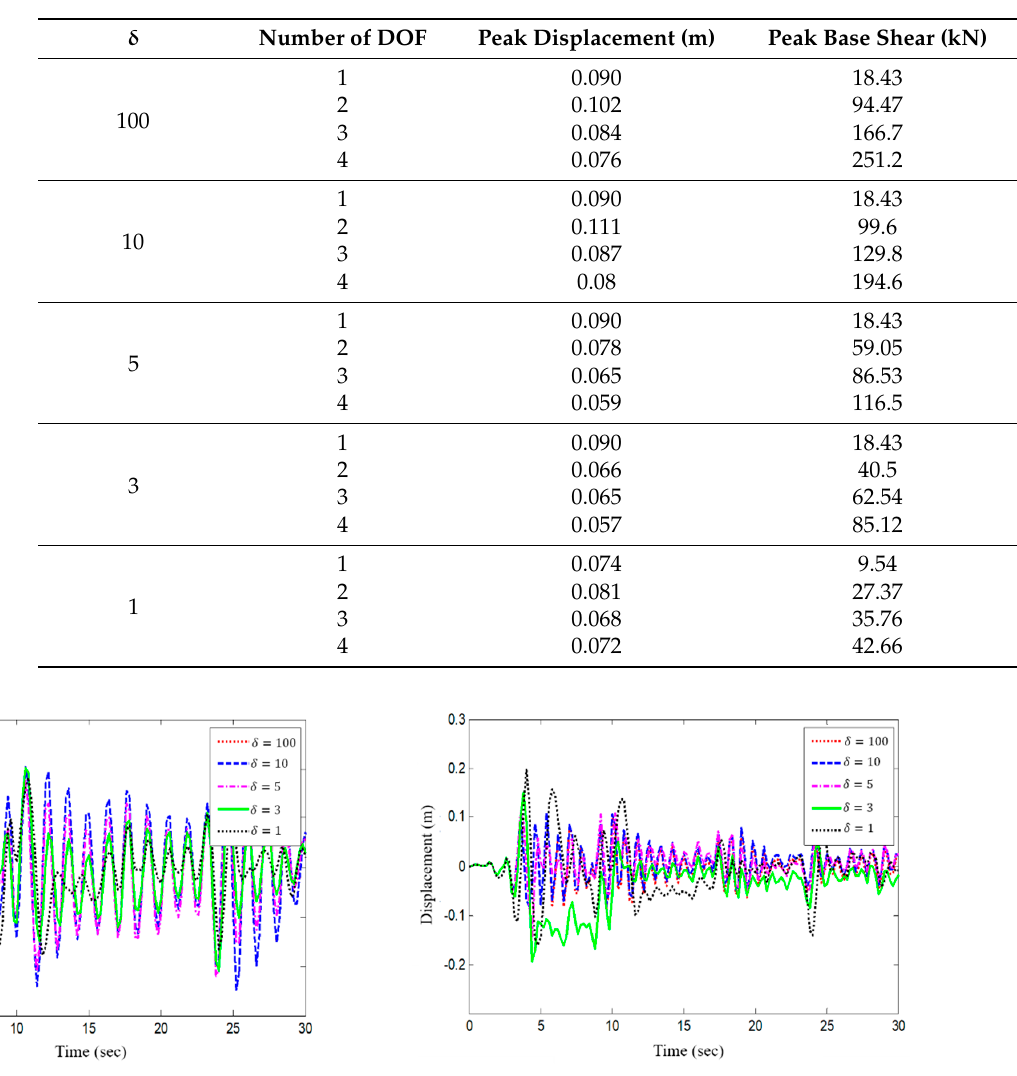
Table 2. Response for varying δ and degrees of freedom.